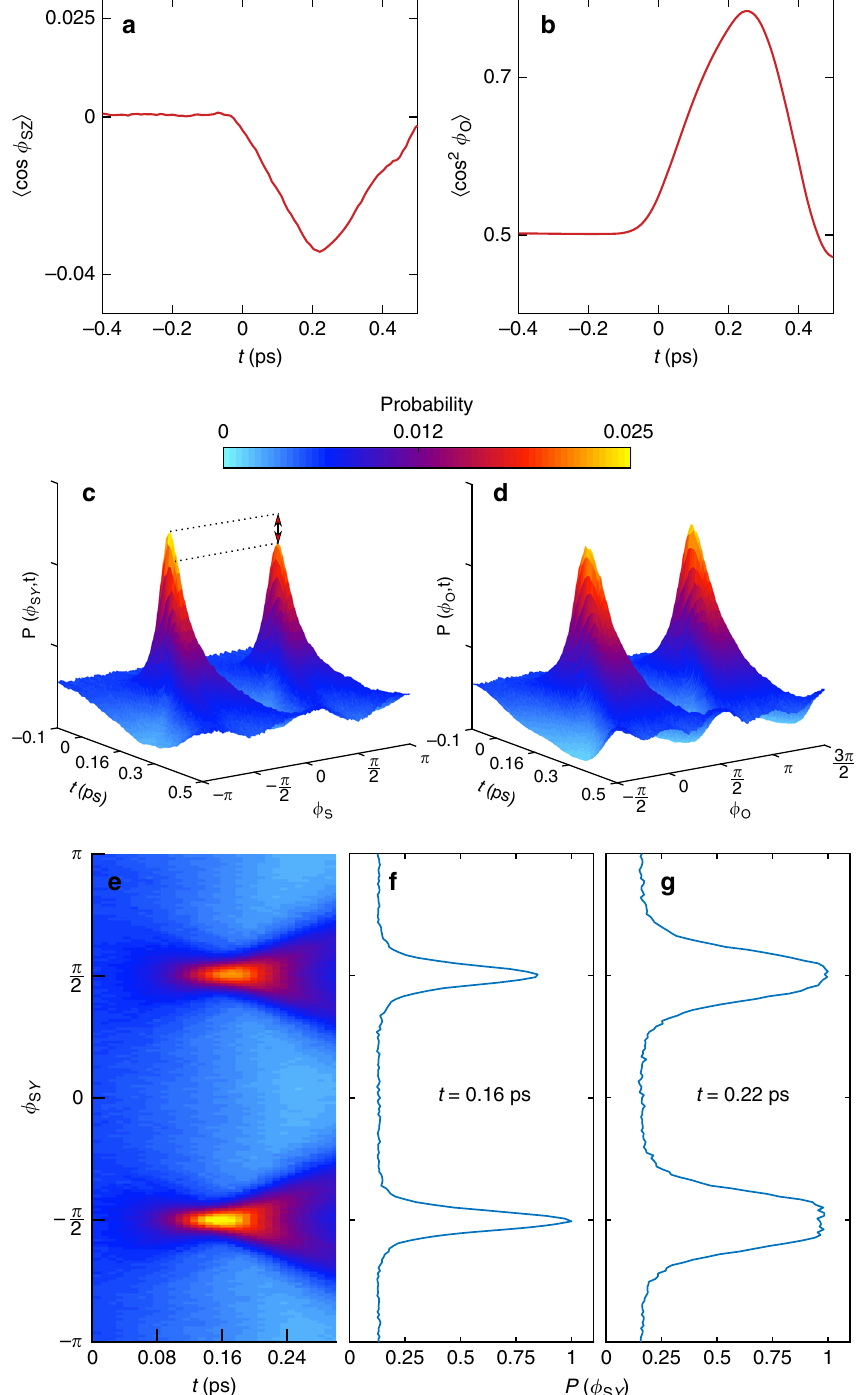
Fig. 3 Results of three-dimensional simulation. a Orientation factor 〈 cos ϕ S Z 〉 ( t ). b Alignment factor 〈 cos 2 ϕ O 〉 ( t ). c 3D surface plot of the time-dependent angular distribution for S -axis. d 3D surface plot of the time-dependent angular distribution for O -axis. e Top view of the 3D surface. f Angular distribution P ( ϕ S Y ) at t = 0.16 ps, the moment of tighter focus around ϕ S Y = − π /2. g Angular distribution of P ( ϕ S Y ) at t = 0.22 ps, the moment of maximal